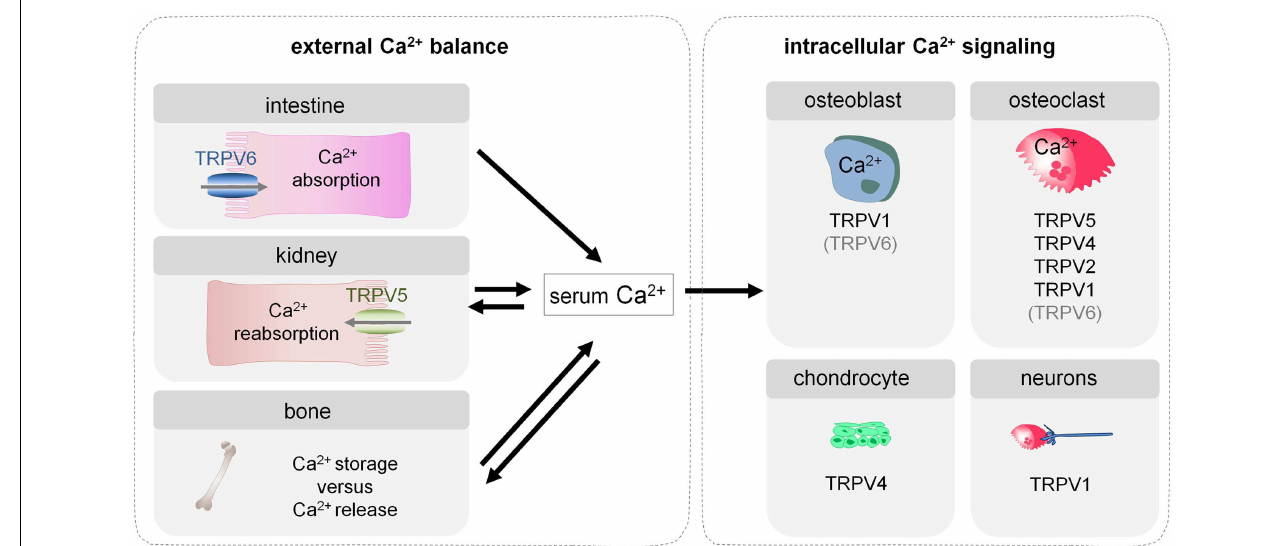
FIGURE 1 | Involvement ofTRP channels in the external calcium balance and intracellular Ca 2 + signaling in bone cells. Bone homeostasis